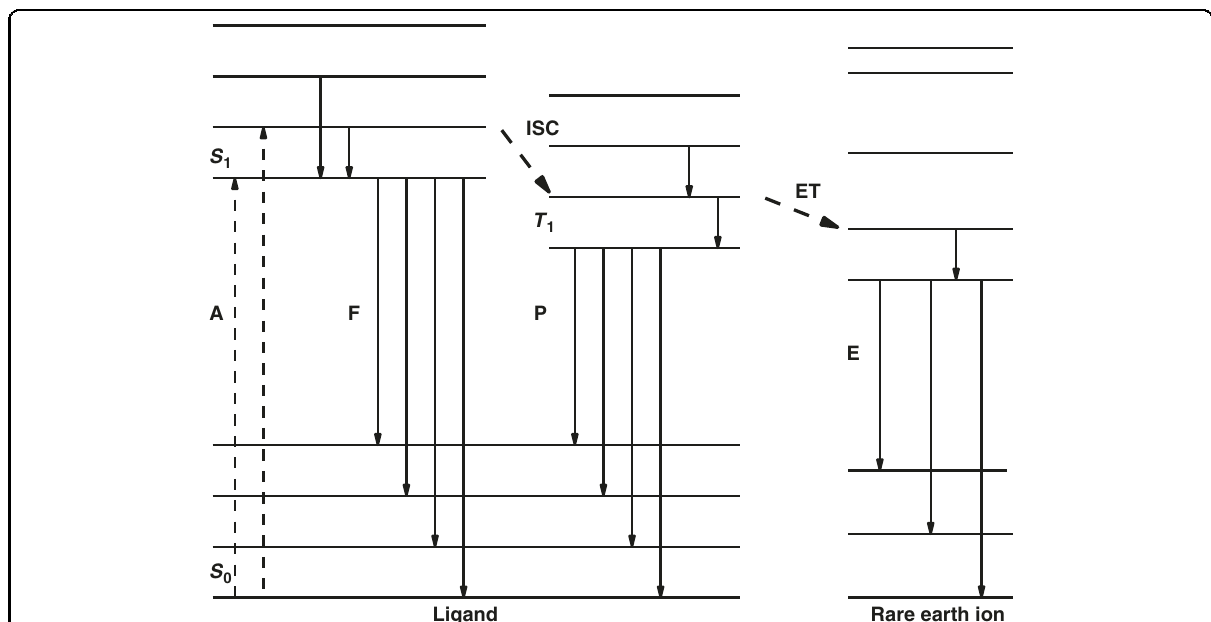
Fig. 2 Photo-physical processes in RE complexes. Here A, F, P, and E stand for absorption, fl uorescence, phosphorescence and emission, respectively; while ISC and ET are intersystem crossing and energy transfer,